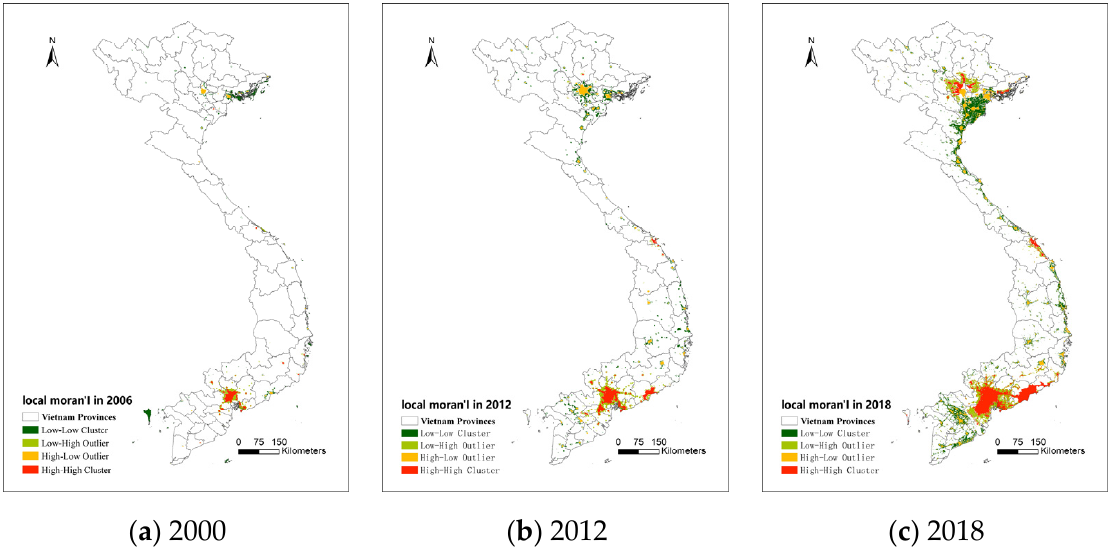
Figure 4. Features of NTL spatial agglomeration.